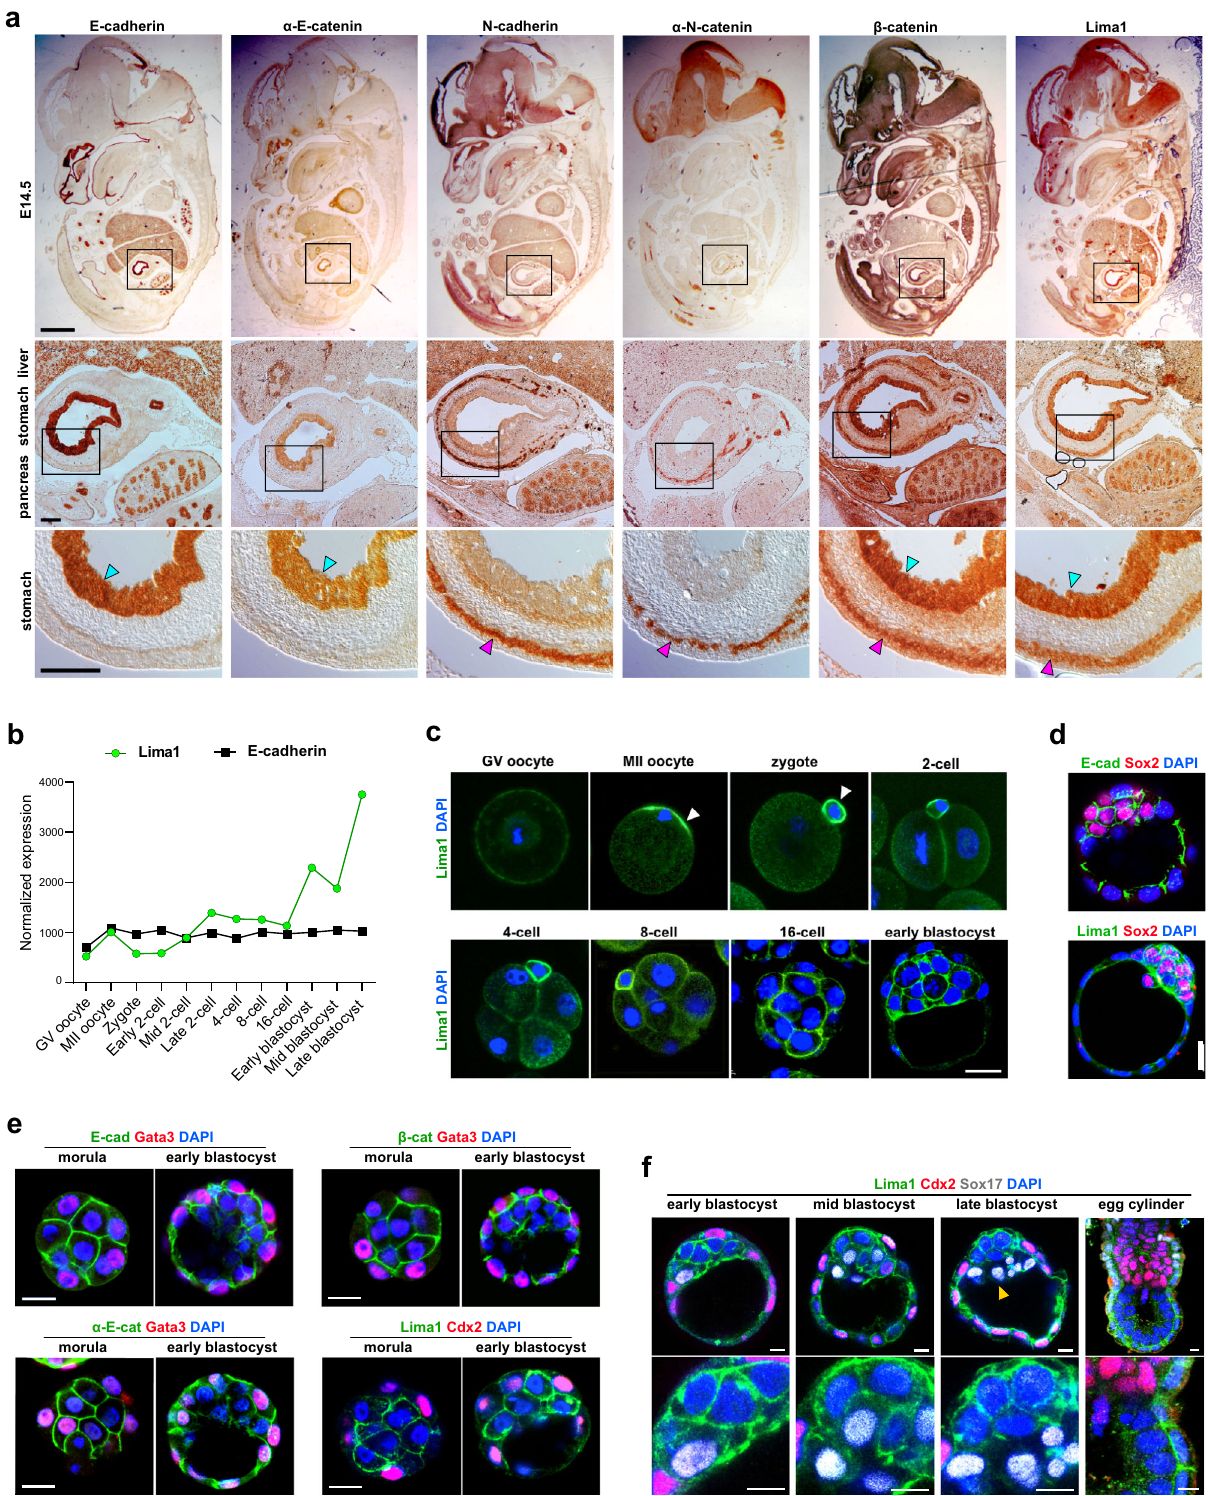
Fig. 1 Lima1 expression pattern during mouse embryonic development. a E14.5 embryos sectioned and stained for E-cad, α -E-cat, N-cad, α -N-cat, β -cat or Lima1. Blue and magenta arrows indicate epithelial and muscle layers, respectively. b Normalized expression levels of Lima1 and E-cad during mouse pre- implantation development, based on Wang et al., 2004. c Oocytes and pre-implantation embryos stained for Lima1. Arrowheads indicate Lima1 localisation on the cortical cap in MII oocyte and in the polar body at the zygote stage. d Blastocyst stage embryos stained for Sox2 and E-cad or Sox2 and Lima1. e Morula and blastocyst stage embryos stained for AJ components, Lima1 and TE lineage markers (Gata3 or Cdx2). f Blastocyst and egg cylinder stage embryo stained for Lima1, Cdx2, Sox17 and DAPI. The PE is indicated by an arrowhead. Scale bars, ( a ), 1000 μ m, upper panel and 100 μ m, lower panels; ( c ), ( d ) and ( e ), 20 μ m; ( f ), 10 μ m. Experiments were repeated independently at least three times with similar results ( a, c, d, e, f ). Related to Figure